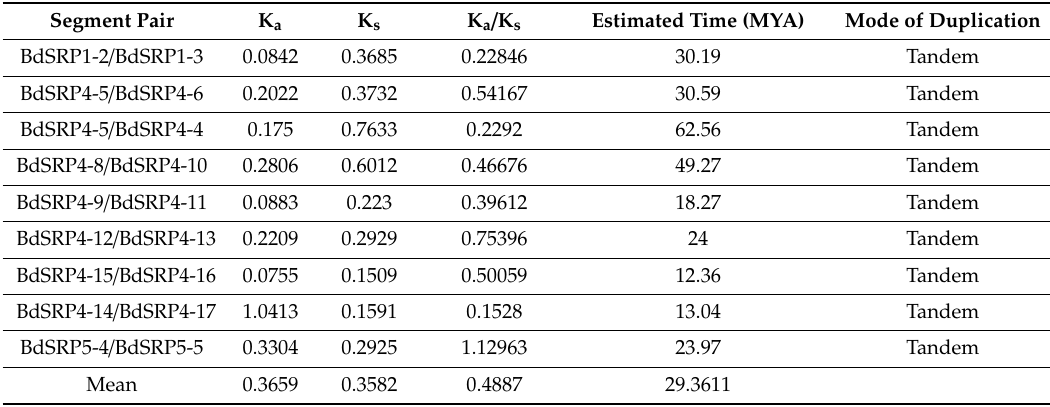
Table 2. The non-synonymous substitution rate (K a ) and synonymous substitution rate (K s ) values and estimated divergence time for tandemly duplicated BdSRP genes. MYA, million years